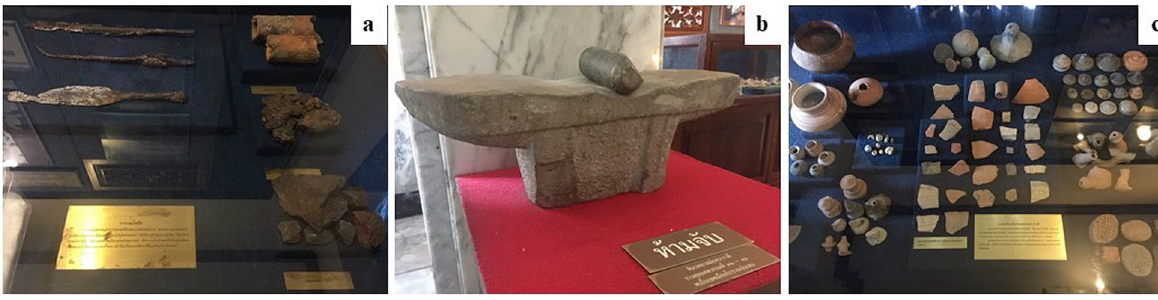
Fig. 3. Archaeological evidence in Nakhon Sawan.